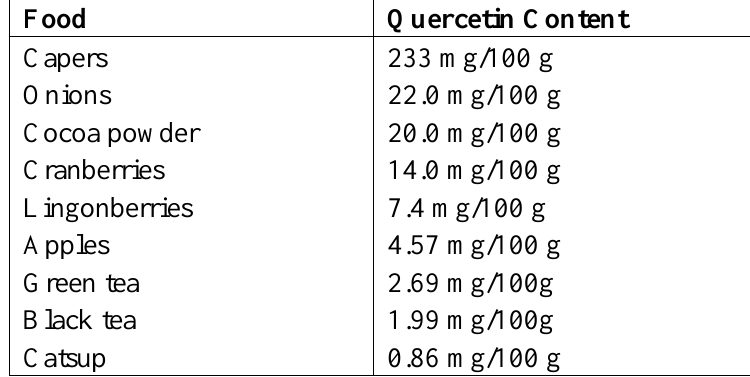
Table 1. Amount of quercetin in selected foods, adapted from the USDA database